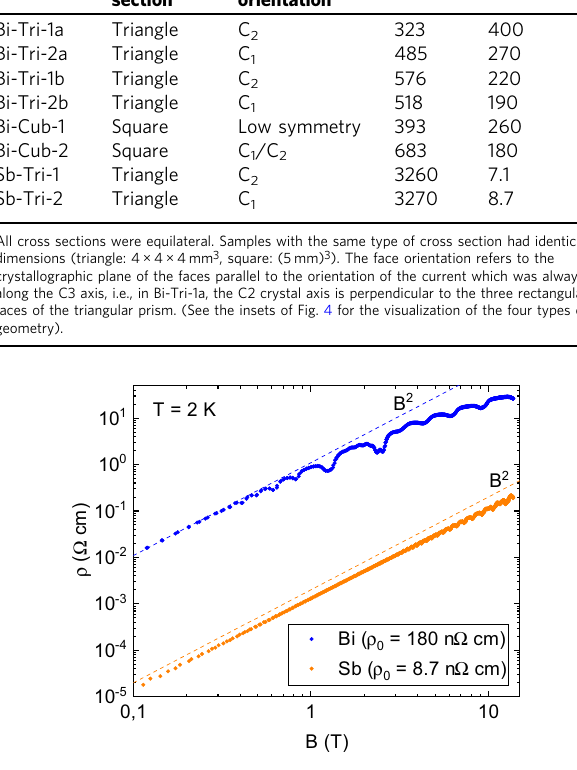
Fig. 1 Amplitude of magnetoresistance. The resistivity increases by 7 to 8 orders of magnitude upon applying a magnetic fi eld of 14 T along a C 1 axis. In Bi, a downward deviation from B 2 behavior at high magnetic fi eld is visible. For Bi-Cub-2, ρ ( B = 14 T)/ ρ ( B = 0) = 1.4 × 10 8 and for Sb-Tri-2, ρ ( B = 14 T)/ ρ ( B = 0) = 2.2 × 10 7